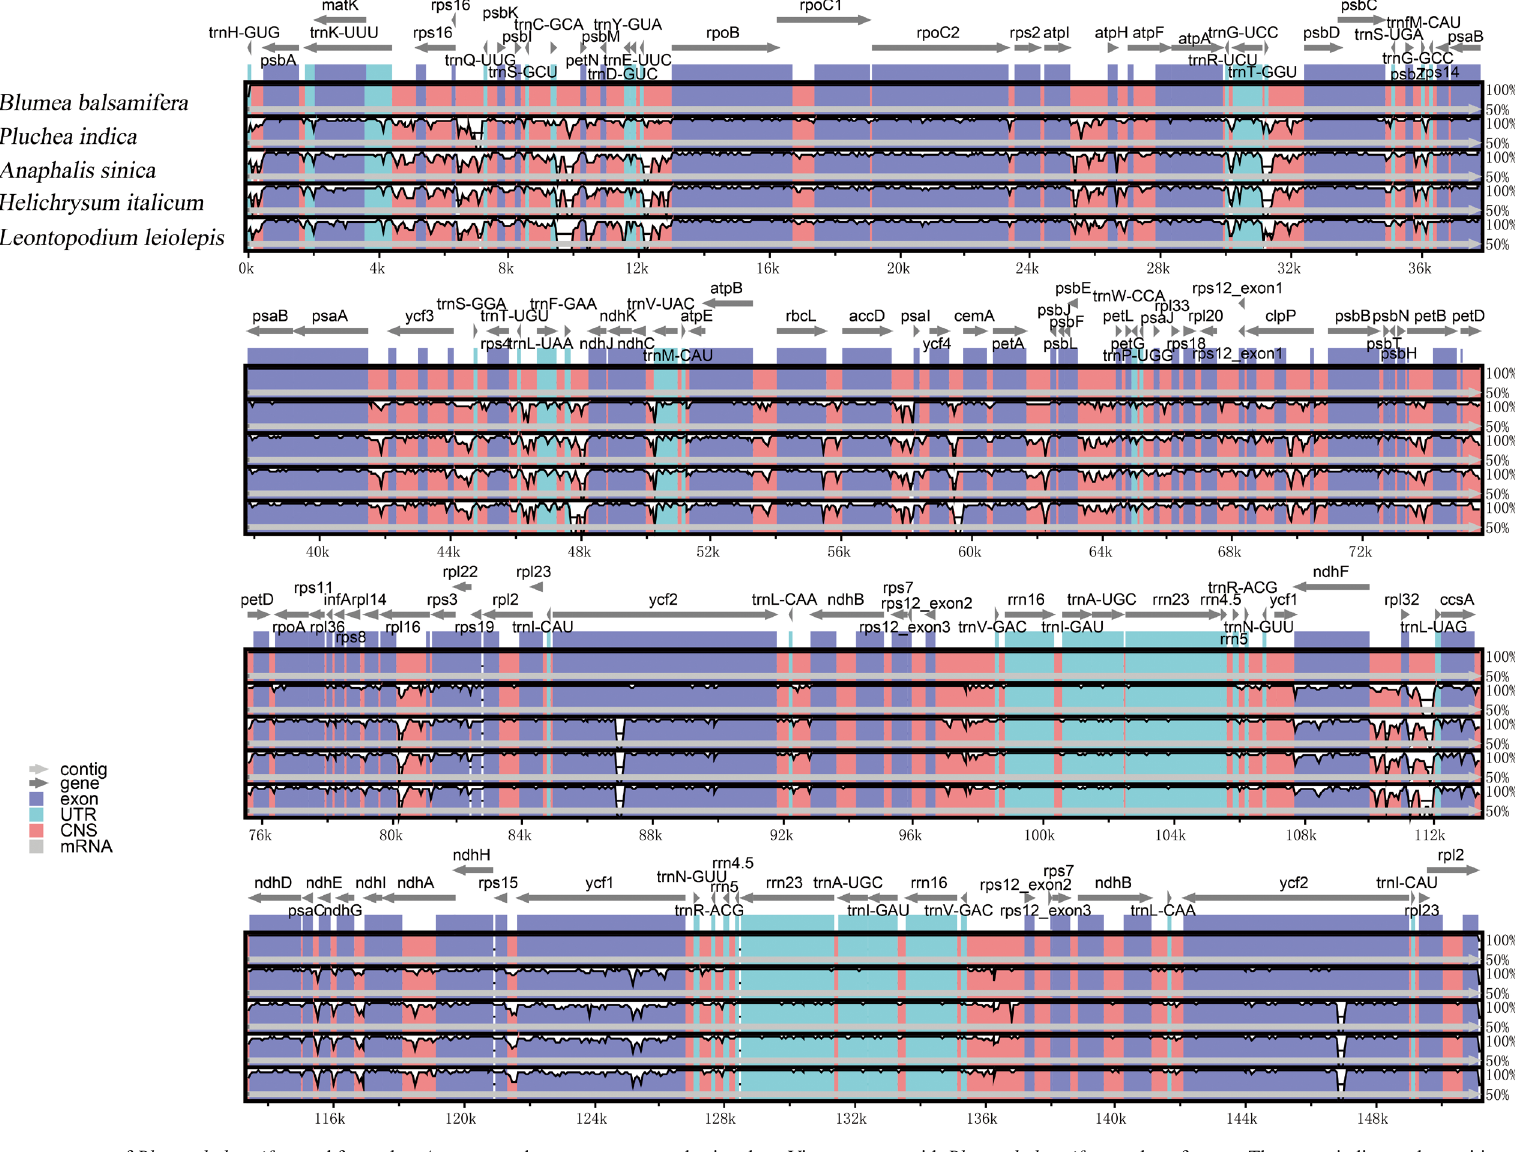
Figure 2 – The cp genomes of Blumea balsamifera and four other Asteraceae plants were compared using the mVista program with Blumea balsamifera as the reference. The arrow indicates the position and orientation of the gene. The Y-axis represents the percentage of identity among genome sequences